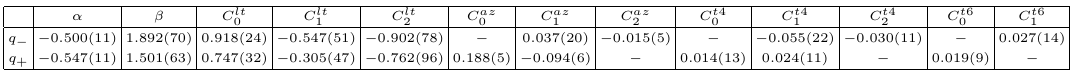
(cid:0) (cid:1) (cid:0) (cid:1) ν, z 2 and Im Y ν, z 2 (cid:0) (cid:1) ν, z 2 are